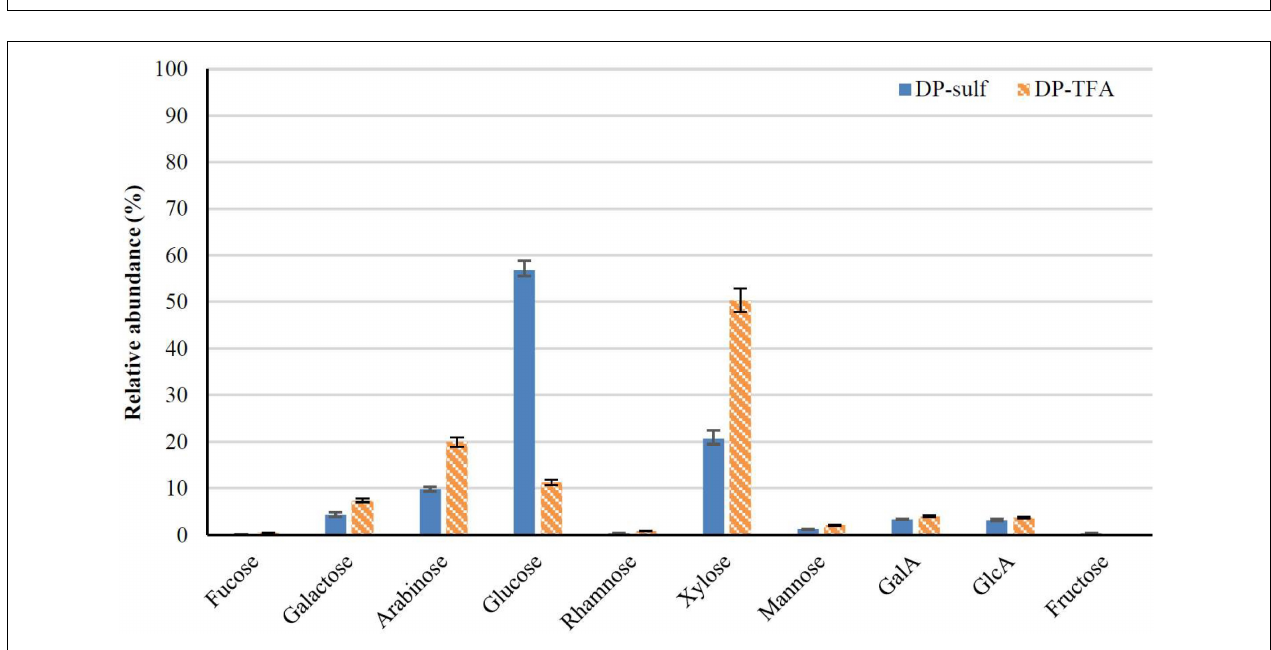
FIGURE 2 | Monosaccharides composition of DP by TFA hydrolysis, expressed as mg per g in a dry matter basis [Glucose (Glc), fucose (Fuc), galactose (Gal), arabinose (Ara), xylose (Xyl), mannose (Man), rhamnose (Rha), galacturonic acid (Gal), and glucuronic acid (GlcA); ( n = 3, mean ± SD)].